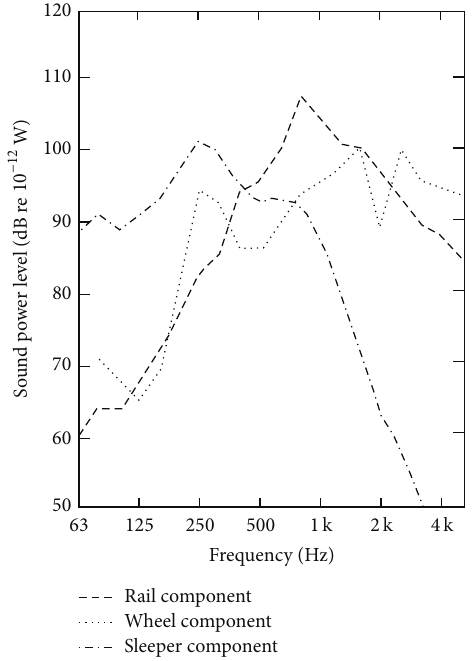
Figure 2: Noise emissions of the track [7,